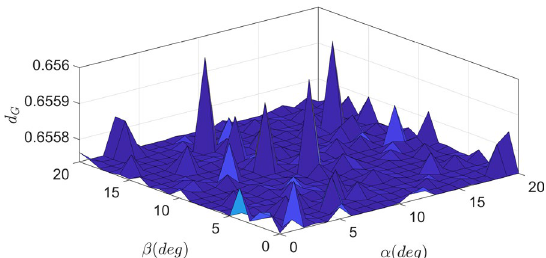
Fig. 15 GNVR “ d G ” parameter